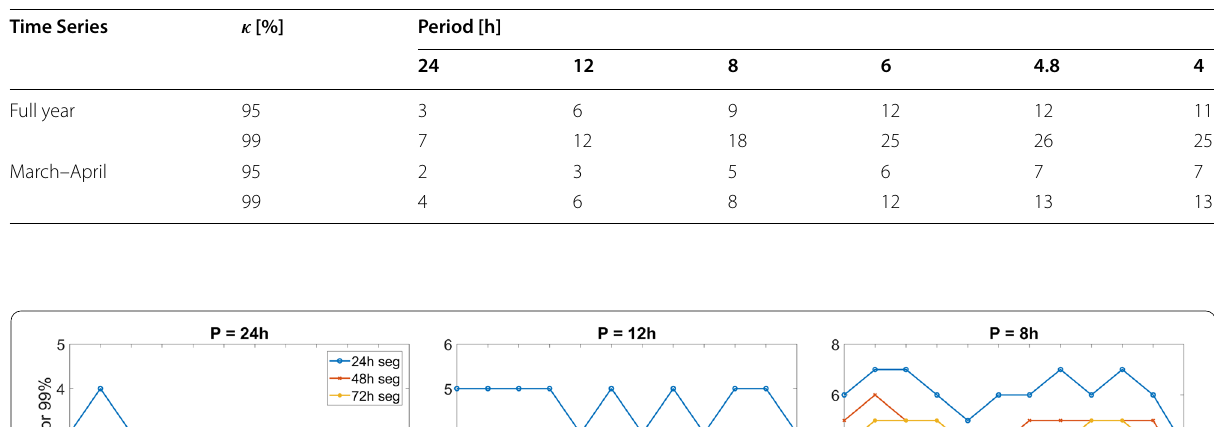
Table 1 Table listing the number of spatial modes needed for each period to surpass either 95 or 99% variance ( κ ) threshold. The list includes PCA results using the full data set and restricting the data to March–April